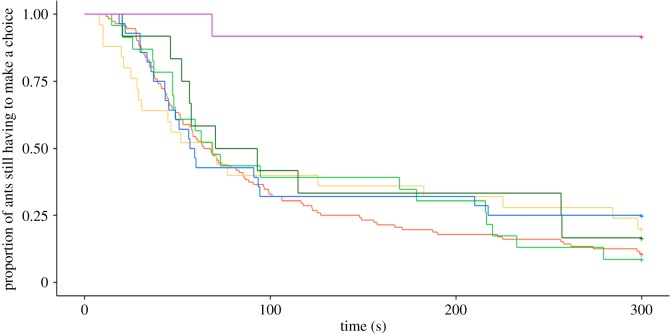
Proportion of ants still having to make a choice as a function of the time elapsed since the first contact with a prey. Curves are drawn for the ants that contacted a single prey and differing by its infectiousness. Orange: control prey (Ctrl, n = 144), yellow: decaying prey (Dc, n = 25), green: prey covered with a low amount of conidia (LC, n = 23), dark green: prey covered with a high amount of conidia (HC, n = 12), blue: fungus-killed prey (FKill, n = 28), violet: sporulating prey (Spo, n = 12).